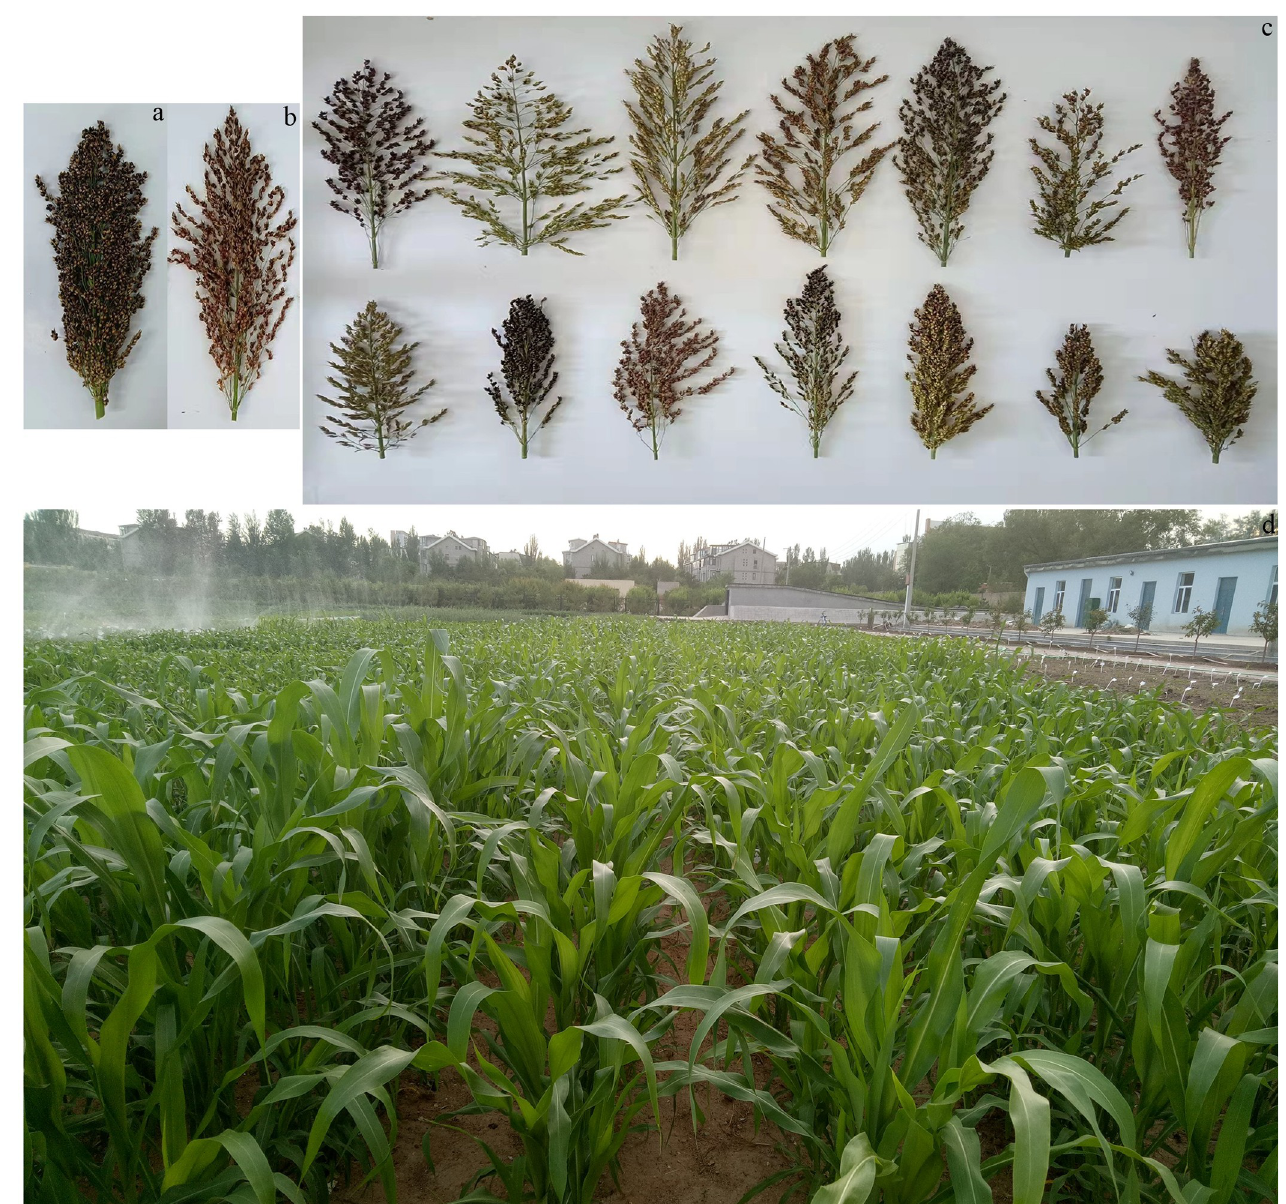
Fig 1. Spike morphology and growth conditions. (a) Comparison of the spike morphology of parent plants. ‘Scattered ear sorghum’ ( ♀ ) (left) and ‘red hull sudangrass’ ( ♂ ) (right). (b) Spike morphologies of the F 2 segregating plants of scattered ear sorghum × red hull sudangrass. (c) Growth conditions of the F 2 segregating